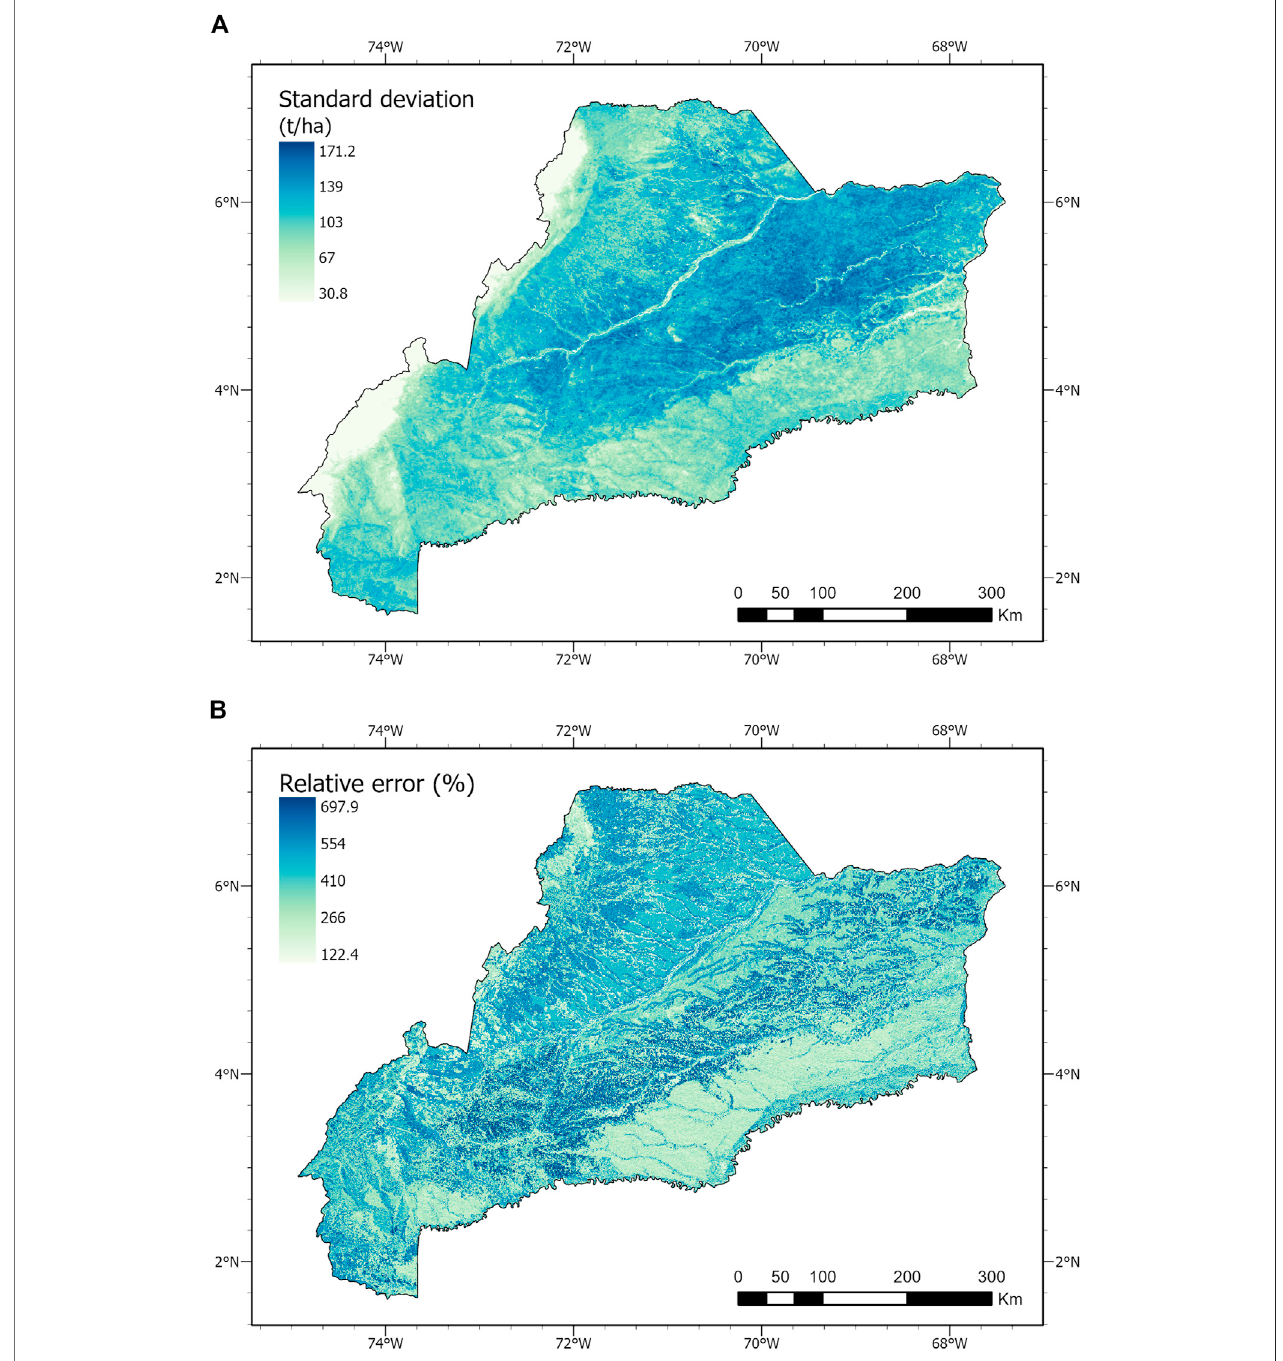
FIGURE 5 | Maps of the (a) standard deviation (t ha − 1 ) and (b) relative error (%) of SOC stock predictions.